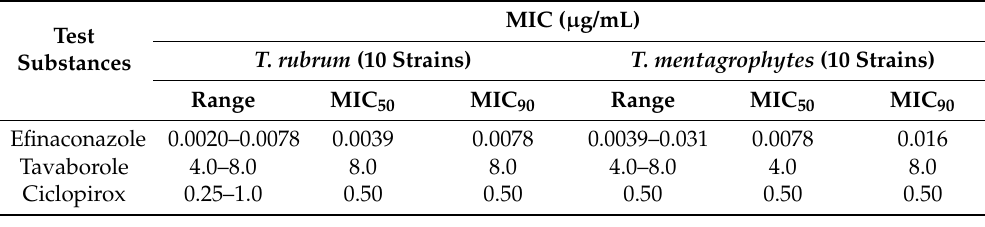
Table 1. MIC range, MIC 50 , and MIC 90 of efinaconazole, tavaborole, and ciclopirox for T. rubrum and T. mentagrophytes.